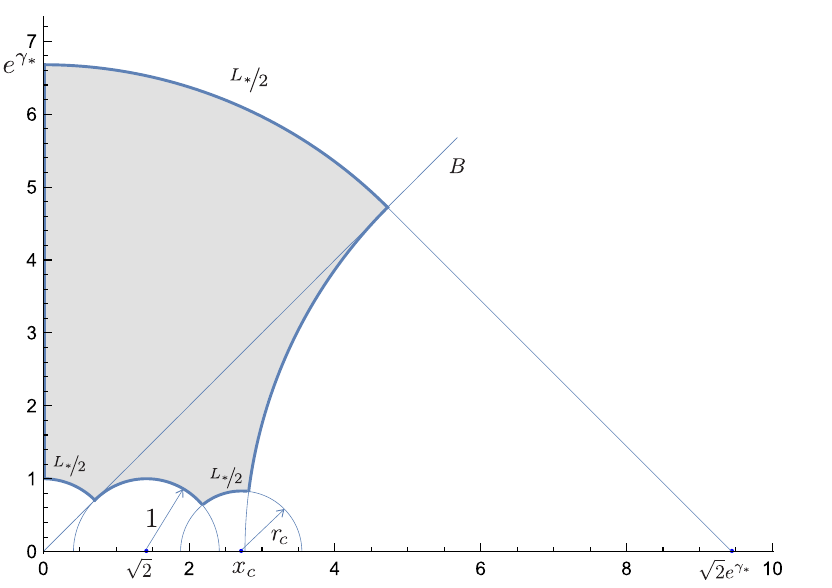
Figure 6 . The hyperbolic vertex V 0 , 3 ( L ∗ ) is constructed by gluing together two hyperbolic hexagons with alternating edges L ∗ and γ ∗ across the γ ∗ edges. The hyperbolic hexagon is shown above, as the shaded area. The line B is at exactly at π/ 4 angle, and the circular arcs from the imaginary axis to B are two sides of length L ∗ / 2 . All other sides are of length γ ∗